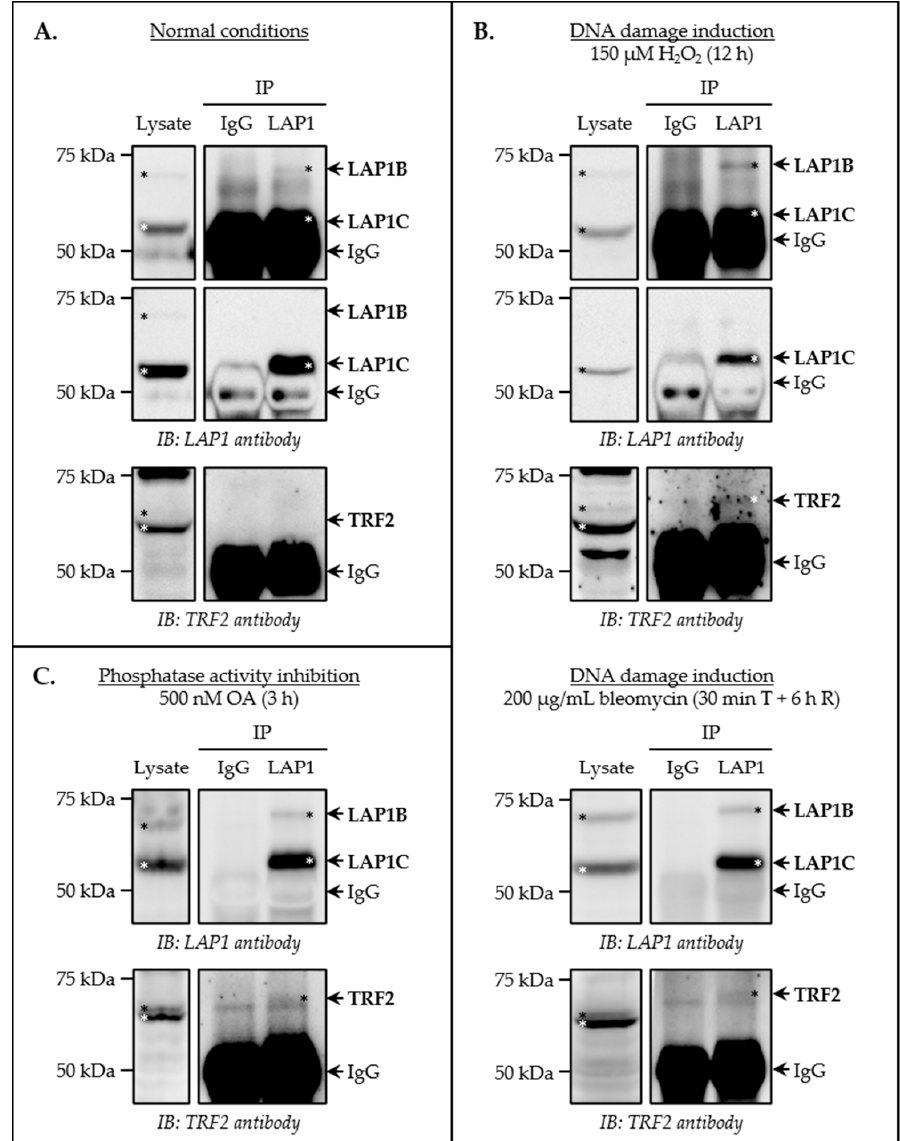
Figure 3. Validation of in vivo LAP1:TRF2 complex formation upon induction of DNA damage and its regulation by protein phosphorylation in the human HeLa cell line. ( A ) LAP1 co-immunoprecipitation assay in control conditions. ( B ) LAP1 co-immunoprecipitation assay after cell exposure to H 2 O 2 (150 µ M for 12 h) and bleomycin (200 µ g / mL for 30 min (T), followed by 6 h of recovery (R)), two DNA-damaging agents. ( C ) LAP1 co-immunoprecipitation assay after cell exposure to okadaic acid (500 nM for 3 h), a serine / threonine-specific protein phosphatase inhibitor. In all assays, HeLa cells’ whole lysates were immunoprecipitated using a Dynabeads Protein G-conjugated LAP1-specific antibody. The corresponding negative controls were performed by incubating total protein extracts with rabbit IgG bound to Dynabeads Protein G. The presence of LAP1 (upper blots in panels A and B (H 2 O 2 ): less exposure time; lower blots in panels A and B (H 2 O 2 ): more exposure time) and TRF2 in the immunoprecipitates (right), as well as in the initial whole cell lysates (left), was analyzed by immunoblotting using specific antibodies. Asterisks indicate visible LAP1B ( ≈ 68 kDa), LAP1C ( ≈ 56 kDa) and TRF2 ( ≈ 69/65 kDa) protein bands in each blot. H 2 O 2 , hydrogen peroxide; IB, immunoblotting; IgG, immunoglobulin G; IP, immunoprecipitation; LAP1, lamina-associated polypeptide 1; OA, okadaic acid; TRF2, telomeric repeat-binding factor